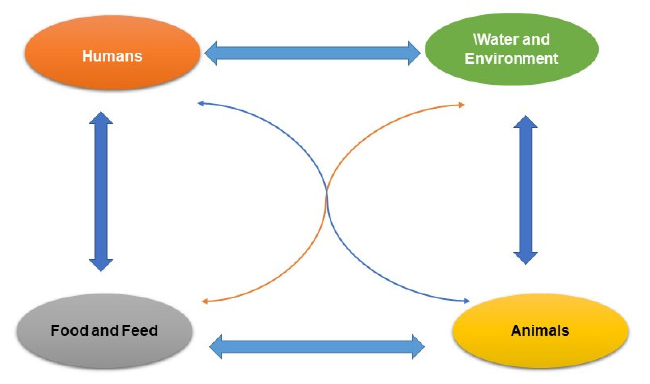
Figure 1. Depicting the potential routes of AMR in the food